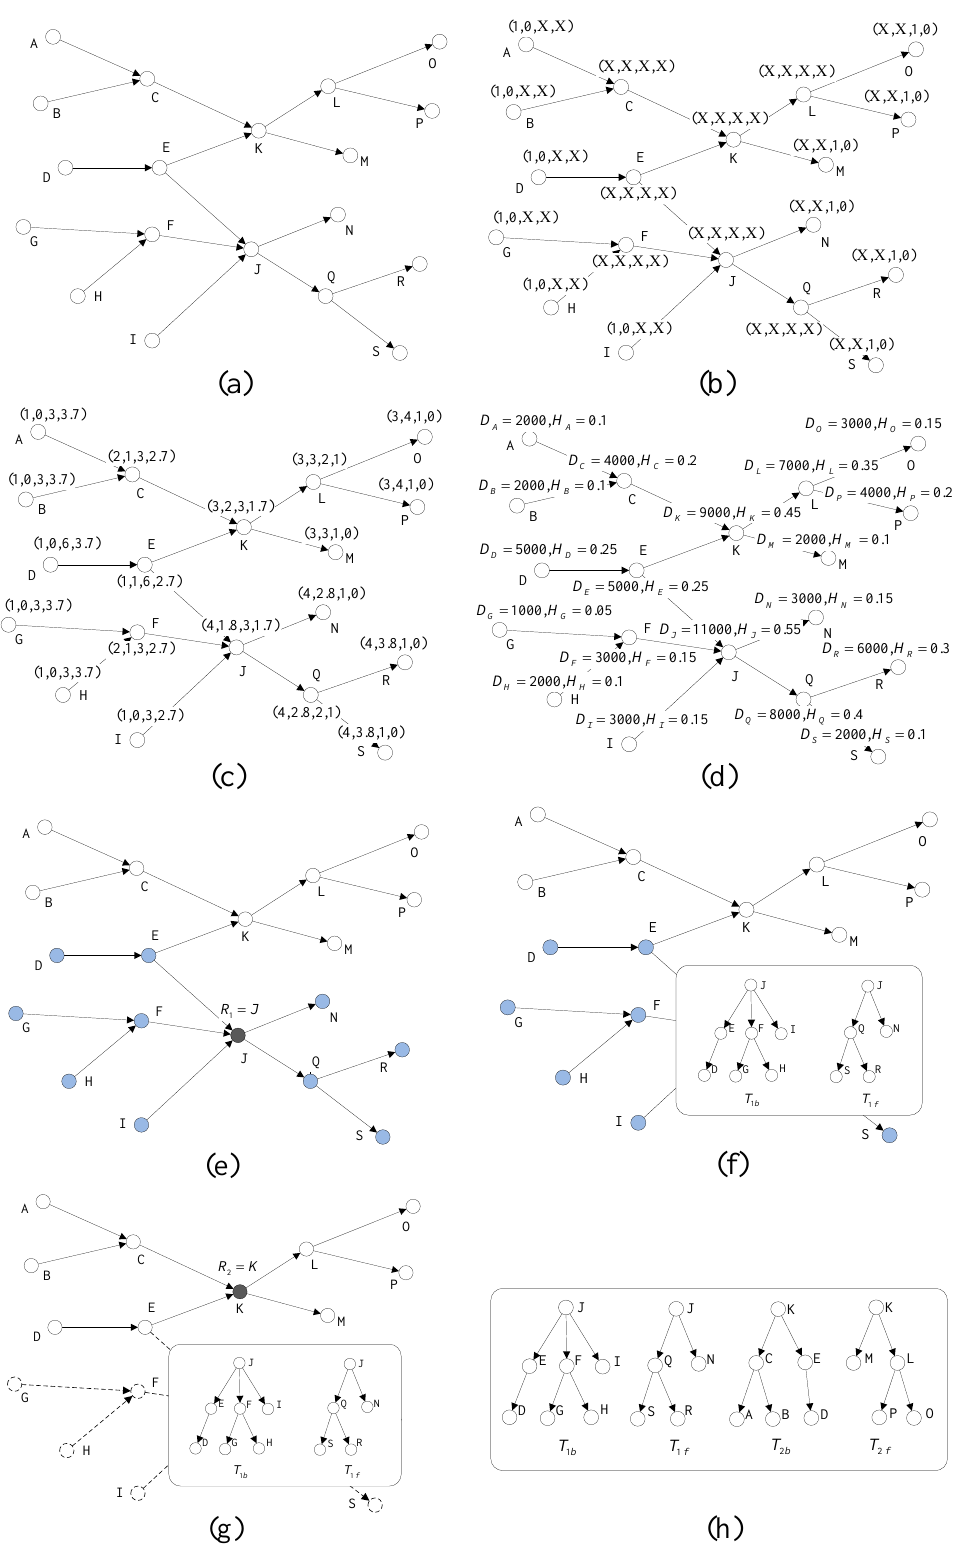
Figure 2. An illustrative example of path splitting. ( a ) Topologic structure of the supply chain; ( b ) Recursive process of the computation of the section-tuples; ( c ) Section-tuples of the nodes; ( d ) Throughput and throughput ratio of nodes; ( e ) The root-node and its covered node set; ( f ) The construction of forward tree and backward tree; ( g ) Remove full-covered set. ( h ) The result of tree structure based path splitting